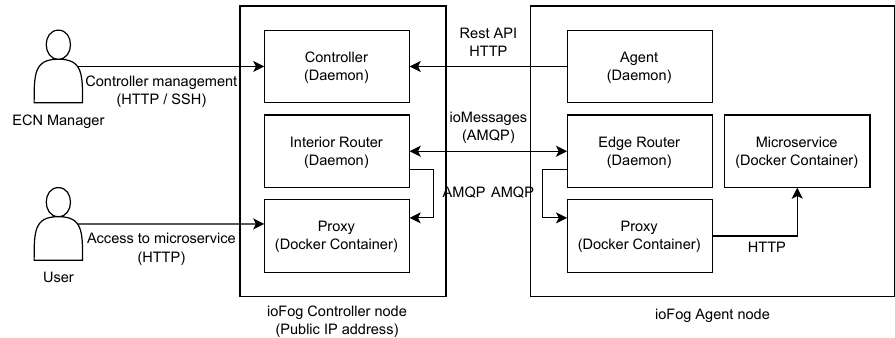
Figure 5. ioFog (v2)